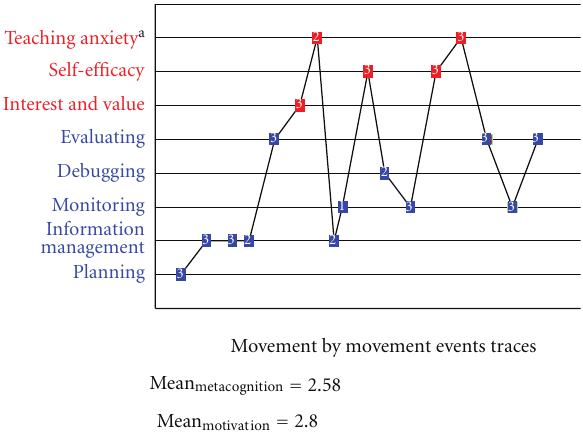
Figure 3: SRL events traces of the participant “A” from the RS group.